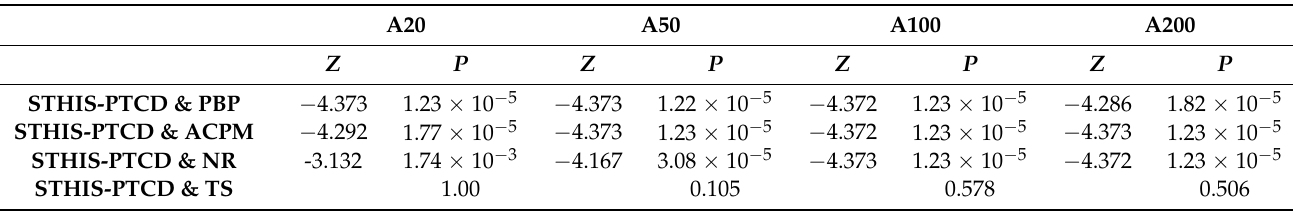
Table 6. Results of Wilcoxon matched-pair signed-rank